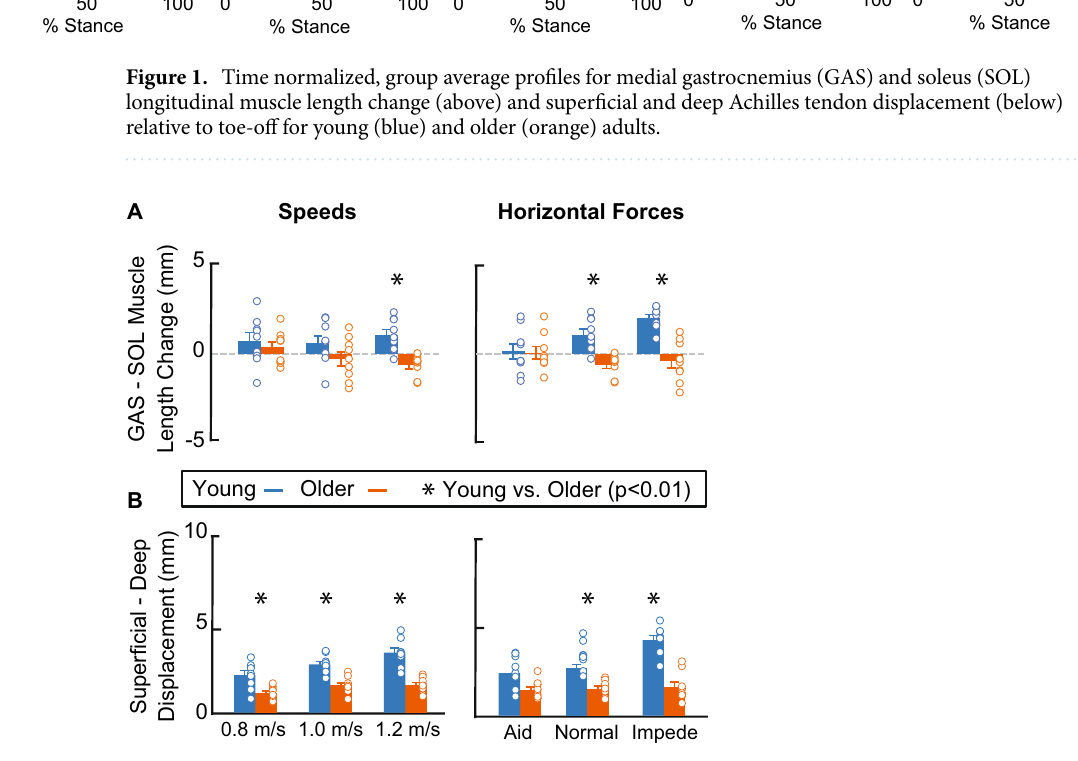
Figure 2. ( A ) Bar plots representing group average peak triceps surae muscle length change heterogeneity (i.e., medial gastrocnemius (GAS)–soleus (SOL) longitudinal muscle length change relative to toe-off). ( B ) Bar plots representing peak Achilles tendon non-uniformity (i.e., superficial—deep subtendon tissue displacements relative to toe-off). Single asterisks (*) represent significant differences between young (blue) and older (orange) adults (P < 0.01). Open circles represent individual data points. Error bars represent standard